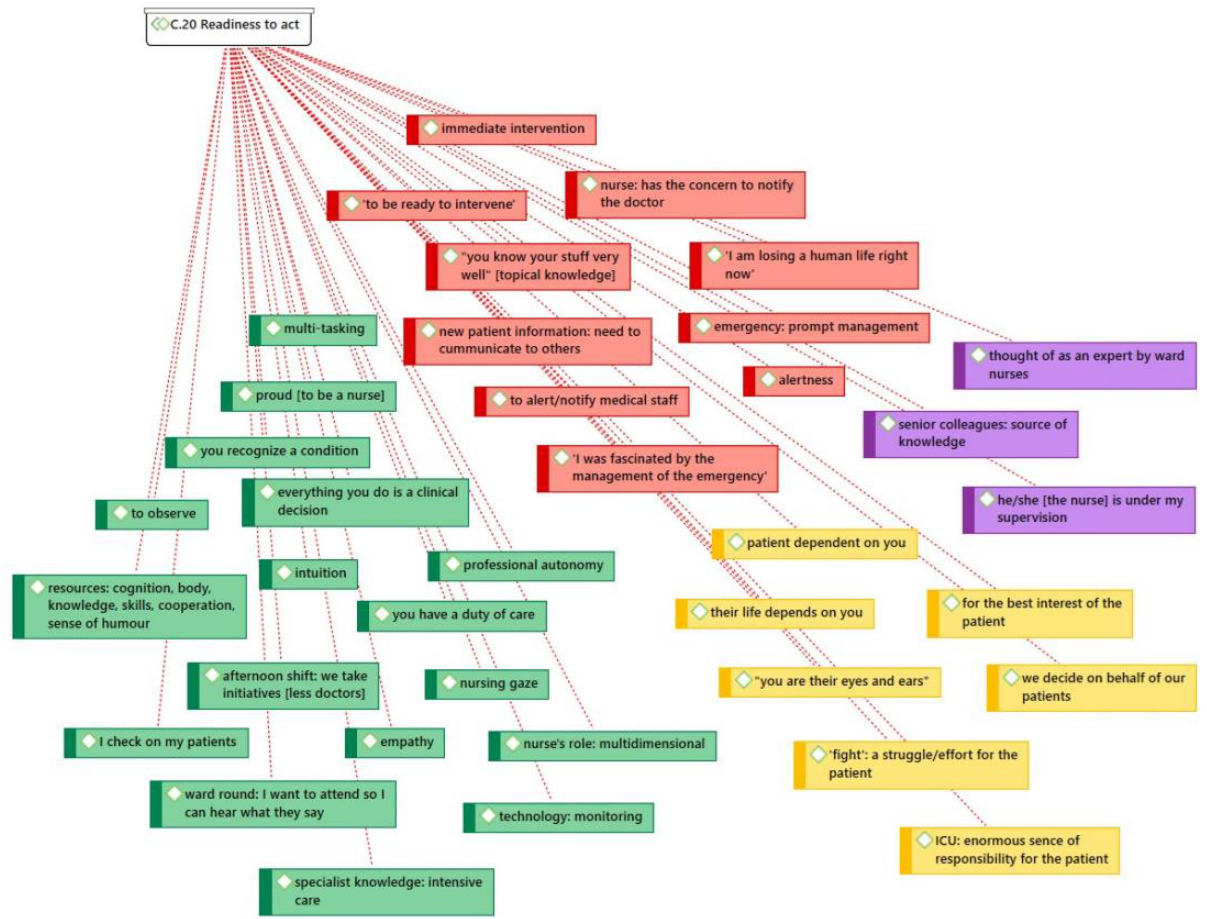
Figure 2. Readiness to